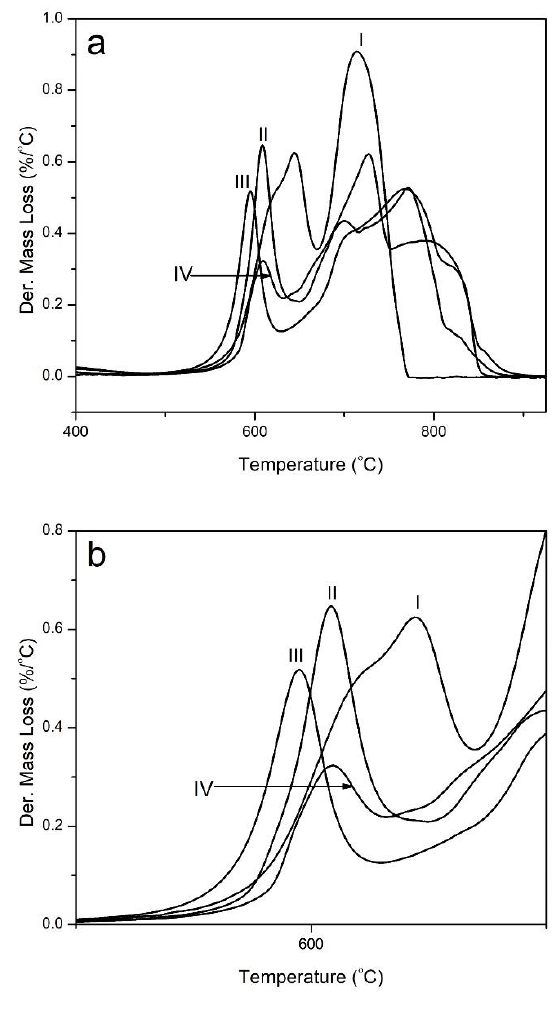
Figure 3. Derivative mass loss curves: ( a ) for (I) Neat PI, (II) PI-10 wt.% graphene, (III) PI-30 wt.% graphene, (IV) PI-50 wt.% grapheme; ( b ) for imide ring decomposition for neat PI (I) and the composites (II–IV).